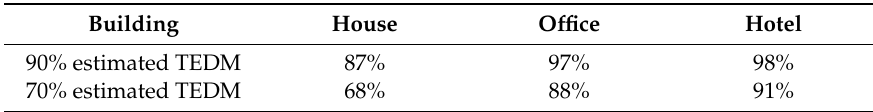
Table 7. Average simulated Total Energy Demand Met (TEDM) by the heat pump in comparison with the TEDM estimated from the building load curves.